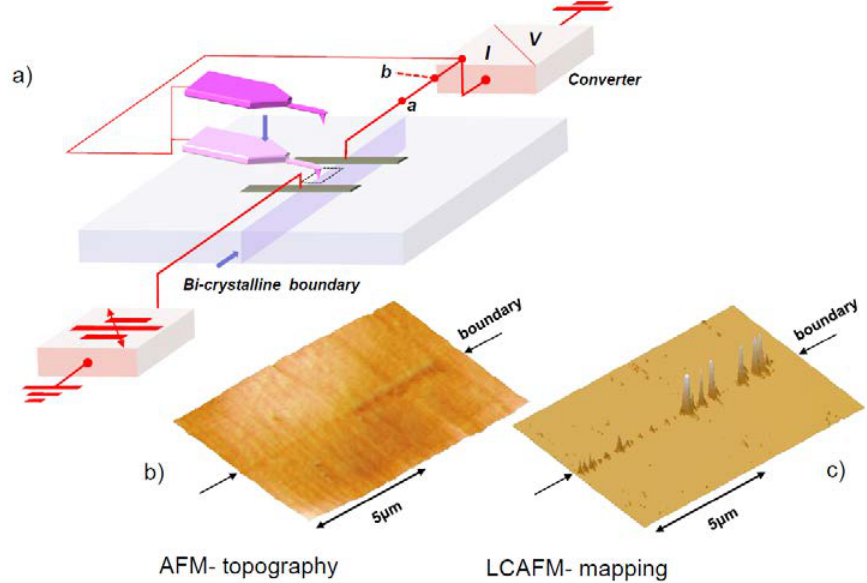
Figure 66. ( a ) Schematic view of an electrodegradation experiment with a bicrystalline boundary where planar electrodes have been mounted on both sides of the crystal and the contacting and electrodegradating the bicrystalline boundary (switcher in position “ a ”). For the switcher in position “ b ” (open), the mapping of the electrical conductivity on the nanoscale using LCAFM could be measured; ( b ) shows a slight change of the topography along the bicrystalline boundary, probably as an effect of an electrically induced migration. Conducting filaments have been preferentially created along the boundary ( c